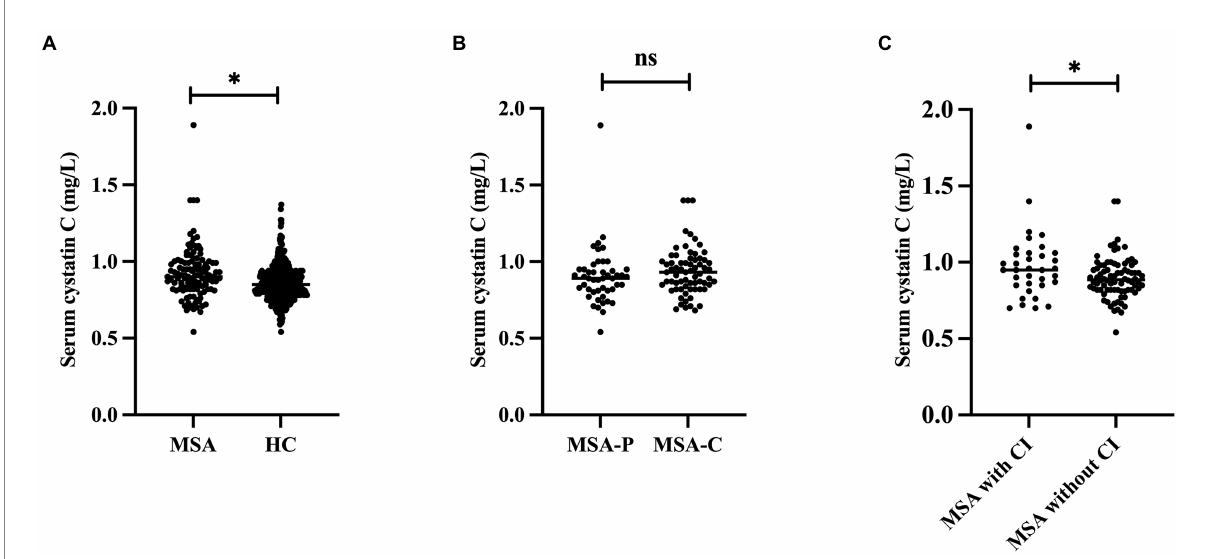
FIGURE 2 Comparison the cystatin C levels between different groups. (A) Comparison the cystatin C levels between MSA and HC. (B) Comparison the cystatin C levels between MSA-P and MSA-C. (C) Comparison the cystatin C levels between MSA with and without CI. *Significant